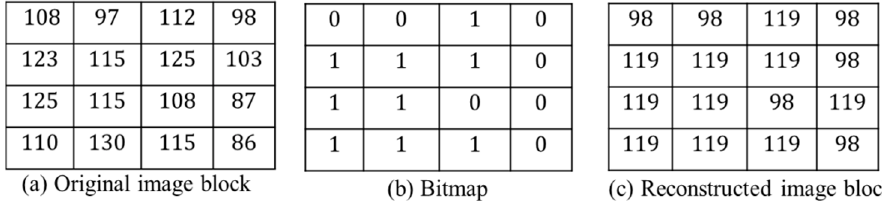
Table 1. Four scenarios for each pixel of a given